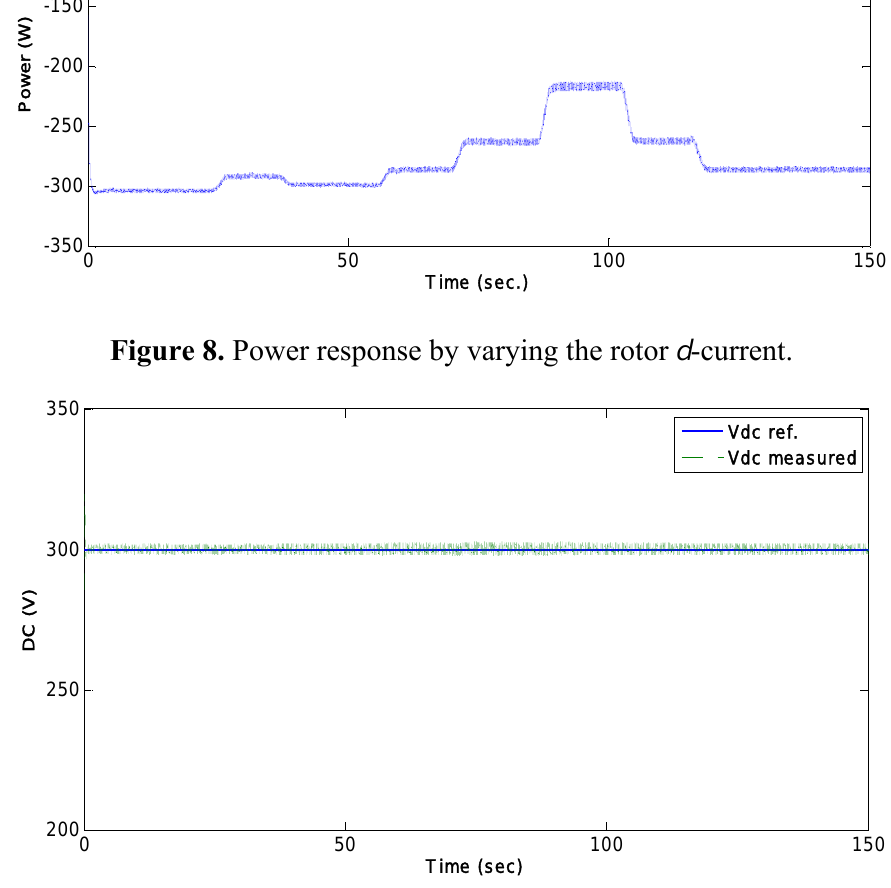
Figure 9. DC-link voltage